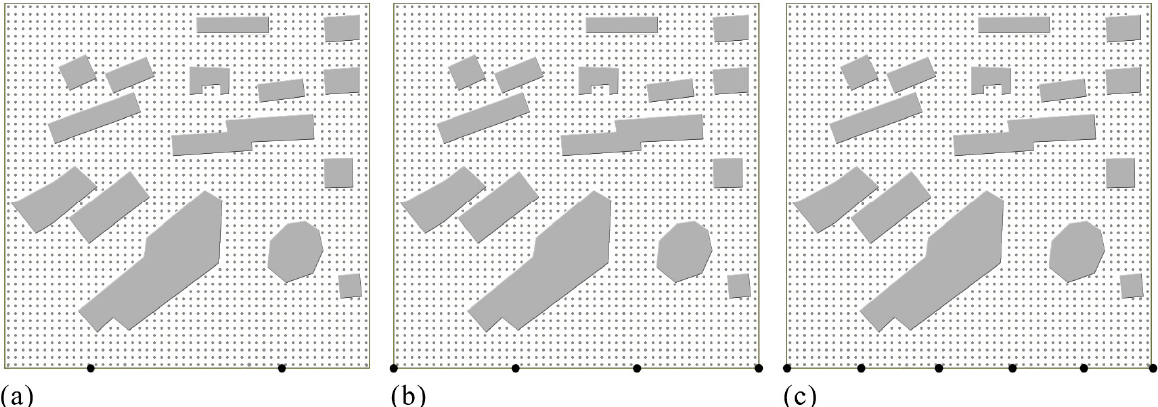
Figure 4. Illustrations of the calculation of noise distribution indices in noise mapping with ( a ) two, ( b ) four and ( c ) six ambient air filters (black dots and grey dots, respectively, denote air filters and receiver points; grey blocks represent buildings in the site).